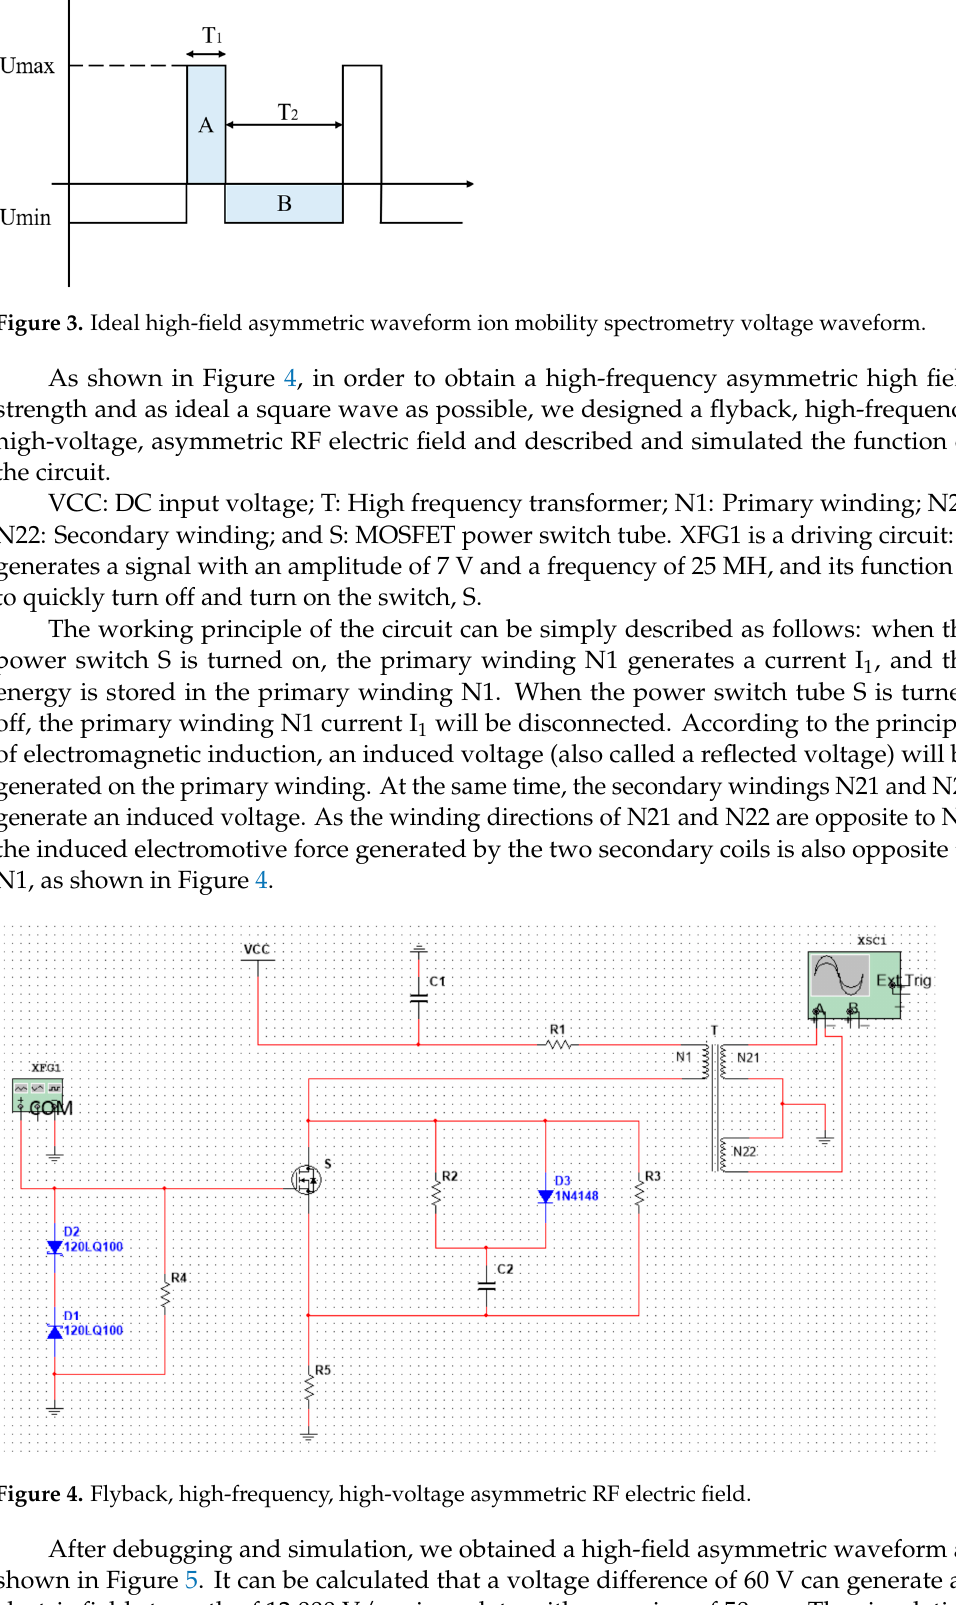
Figure 5. The simulation result of high-field asymmetric waveforms. 2.3. Manufacturing Steps of the Sensor When preparing the FAIMS-VOC gas sensor, we chose double-polished silicon wa- fers ((Suzhou Research Materials Micro/Nano Machining Center) and BF33 glass (Beijing GIN KOO MEMS Scientific & Technological Co., Ltd., Beijing, China) as the chip sub- strates. The ion migration area was designed and prepared on the glass, and the ion de- tection area was designed and prepared on the glass. The chip preparation was then com- pleted by anodic bonding. The main process flow is shown in Figure 6: (a) A 4 inch, dou- ble-sided, polished silicon wafer with a thickness of 300 μ m was selected for the experi- ment, and the silicon wafer was cleaned according to the RCA standard cleaning method,